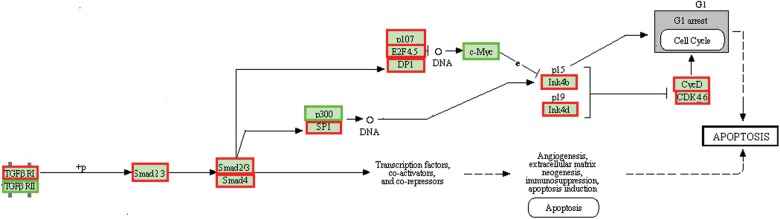
The part of the TGF-β pathway depicted from KEGG pathways, where we observe similar changes in transcript levels of genes between both types of treatments (K562 EV and the 32-nt synthetic RNA) in both BJ and HUVEC cells. The pathway highlights a common response of transcript levels of most genes in this part of the pathway.